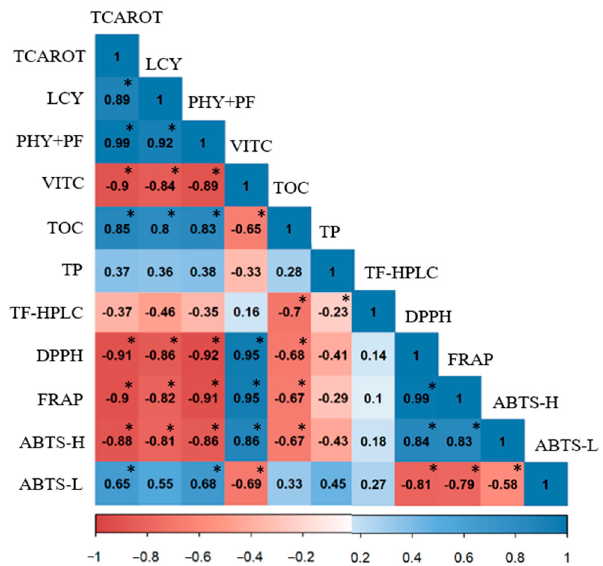
Figure 5. Matrix correlation between total carotenoids (TCAROT), vitamin C (VITC), tocopherols (TOC), total phenolics (TP), total flavonoids (TF), total flavonoids by HPLC (TF-HPLC) and antioxi- dant capacity (DPPH, FRAP, ABTS-H, and ABTS-L) values obtained in the different juices of N, CC and K. Positive and negative correlations are shown in different shades of blue and red, respectively. Significant Pearson’s correlation coefficient ( p < 0.05) is indicated with an asterisk.